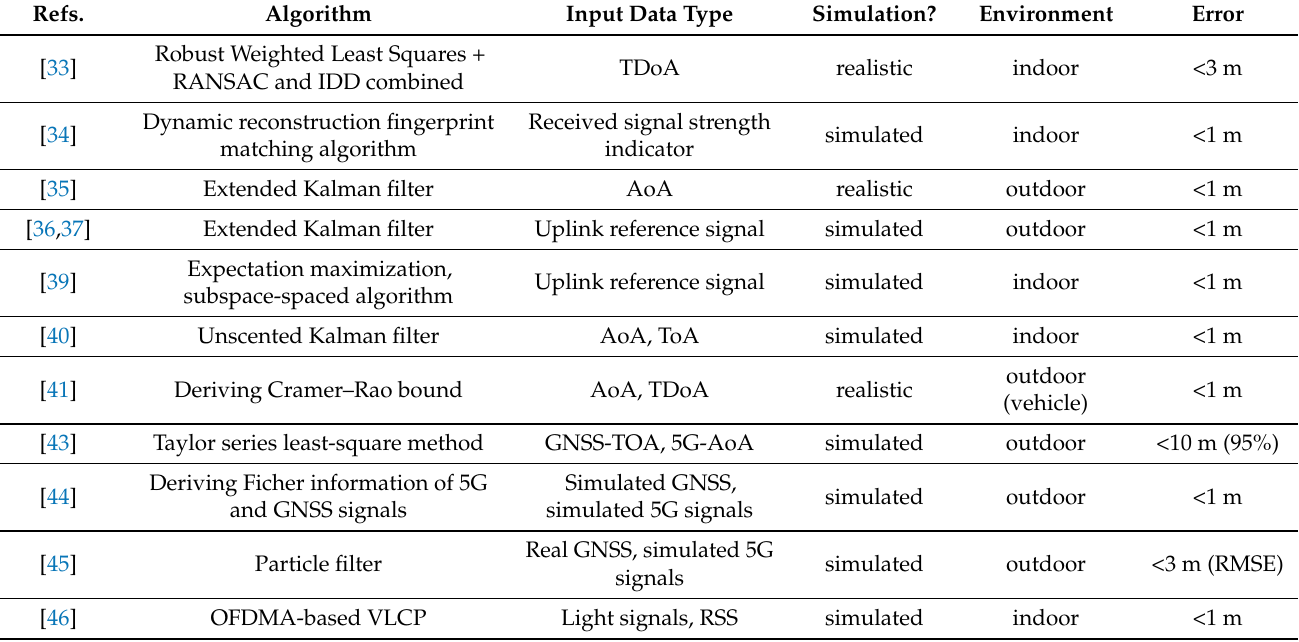
Table 1. Comparison of the conventional positioning techniques in 5G networks.